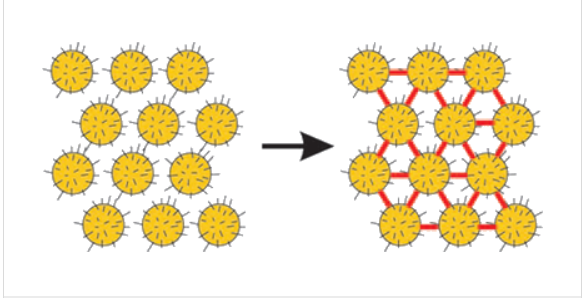
Figure 6: Cross-linking of gold nanoparticles stabilized by octanethiols and connected to each other via diarylethene molecules after the illu- mination with UV irradiation. Reprinted with permission from [116], copyright 2009 American Chemical